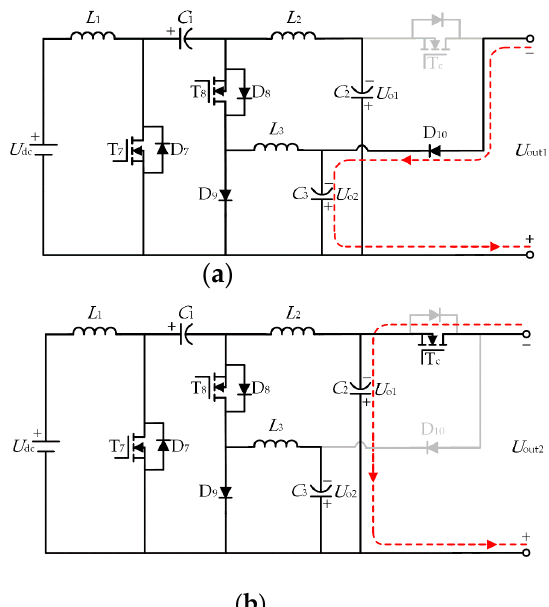
Figure 5. The equivalent circuits under different voltage scalars: ( a ) V m1 ; and ( b ) V m2. V m1 : As shown in Figure 5a, T c is turned on, D 10 is reversely cut off, the output of the SIDO Cuk converter C 3 is used as the overall output of the voltage regulating circuit, and, at this time, C 3 is used alone for the motor power supply; the inverter input voltage to meet U in = U out1 = U o2 .